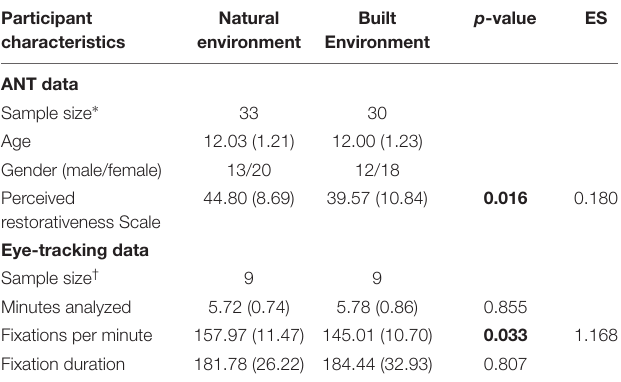
TABLE 1 | Participant details and eye-tracking